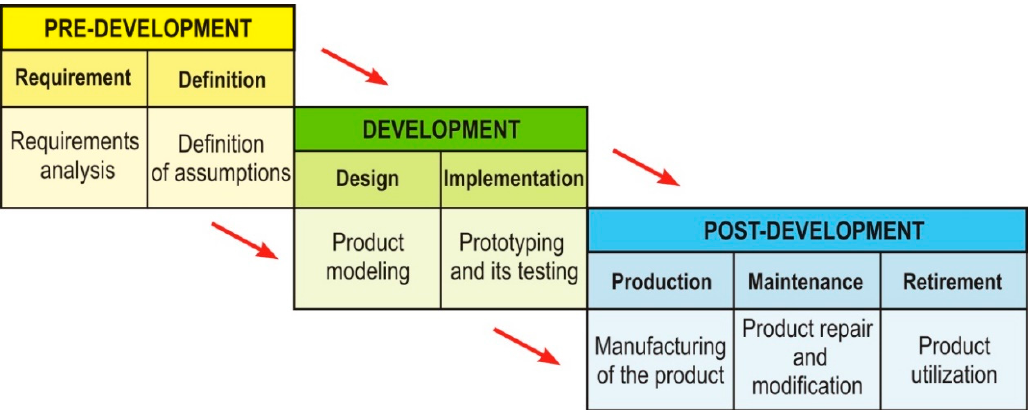
Figure 2. A simplified, classic PDP. Source: own study.